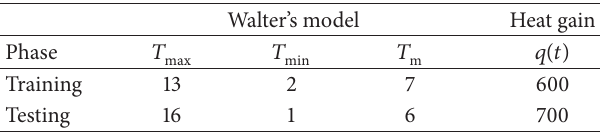
Table 1: Training and testing parameters for outer temperature model and heat gain.